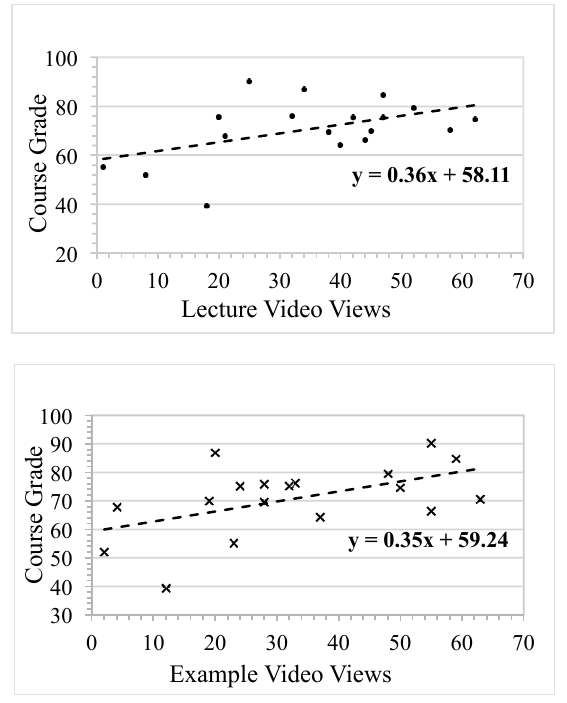
Fig. 7. Final course grades vs. Lecture and Example Video Views, including rate of academic improvement per view.